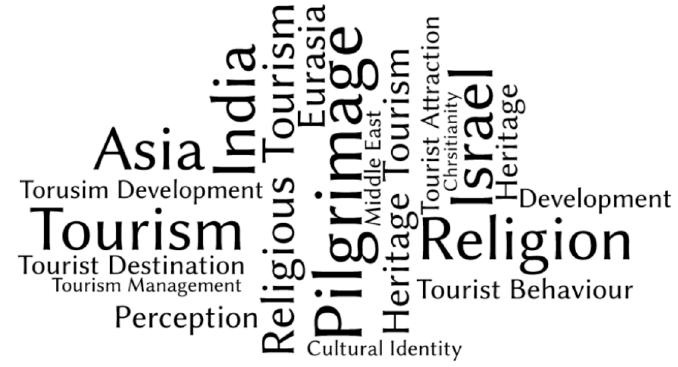
Figure 5. Cloud of keywords included in the articles. ( Source: Own elaboration ).